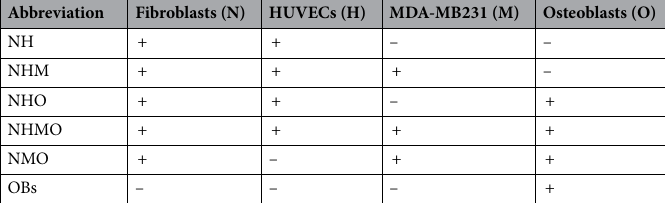
Table 1. List of different tissue